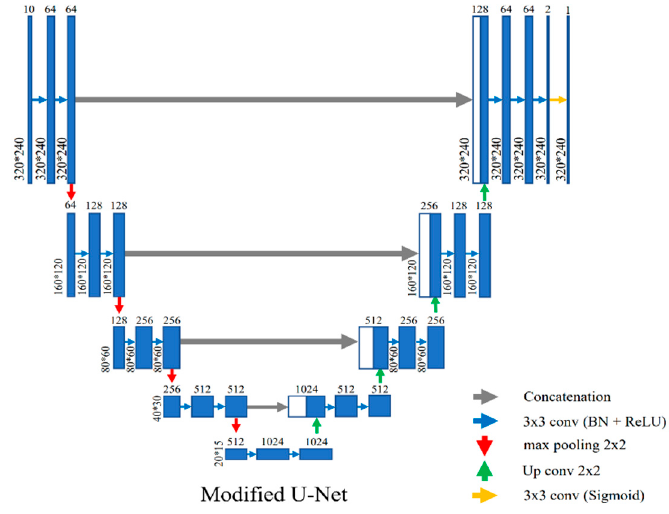
Figure 3. The structure of modified U-Net.